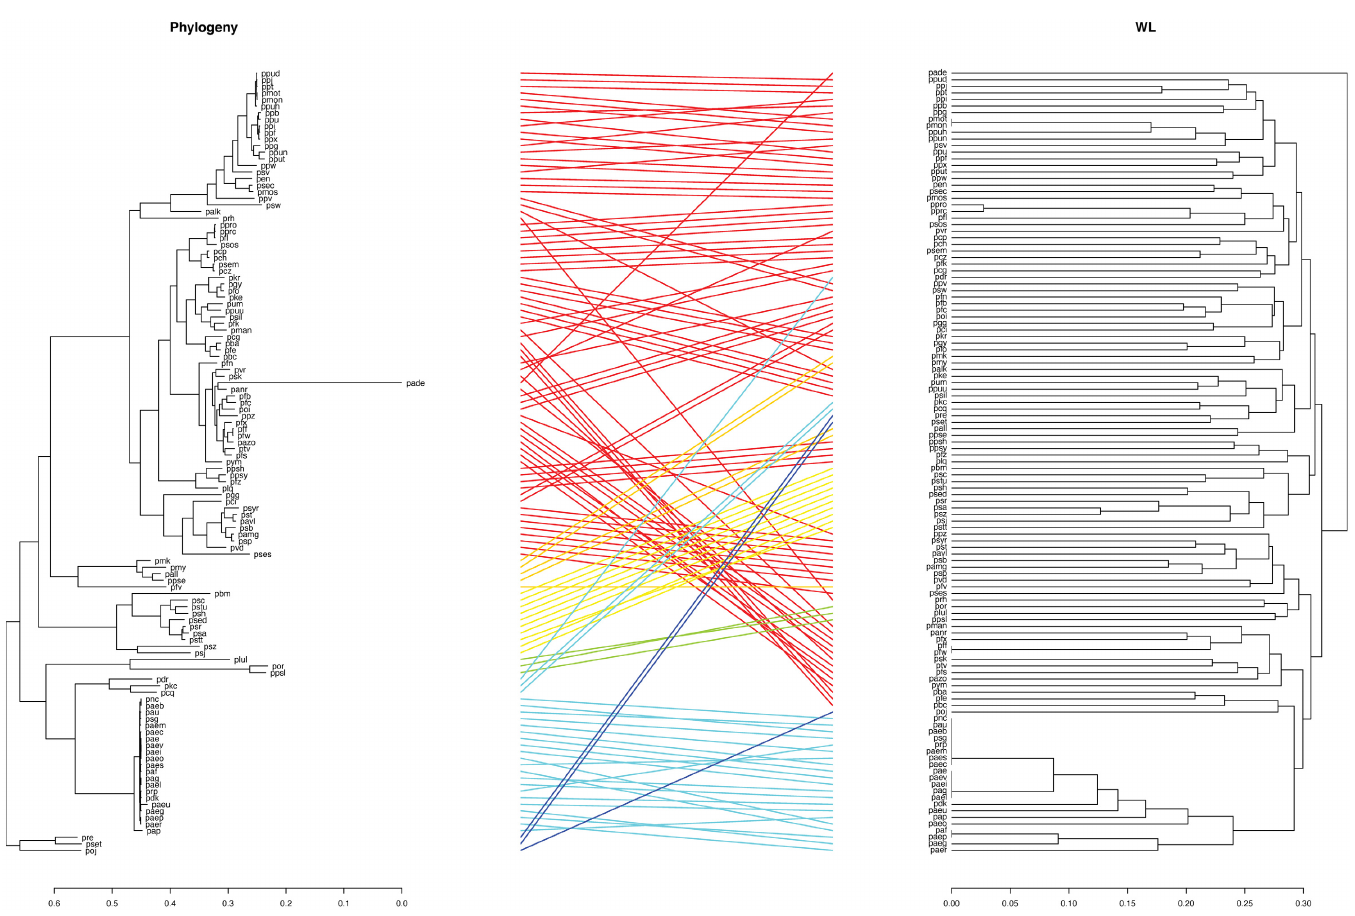
Fig 9. Comparison between Pseudomonas phylogeny and complete-linkage hierarchical clustering obtained with the WL graph kernel. The lines colour legend is as follows. The colours were assigned based on the position of the cluster within the phylogenetic tree. Blue was assigned to the deepest branching cluster followed in order by turquoise, green, yellow, orange and, finally, red which was assigned to the most recent branching cluster.